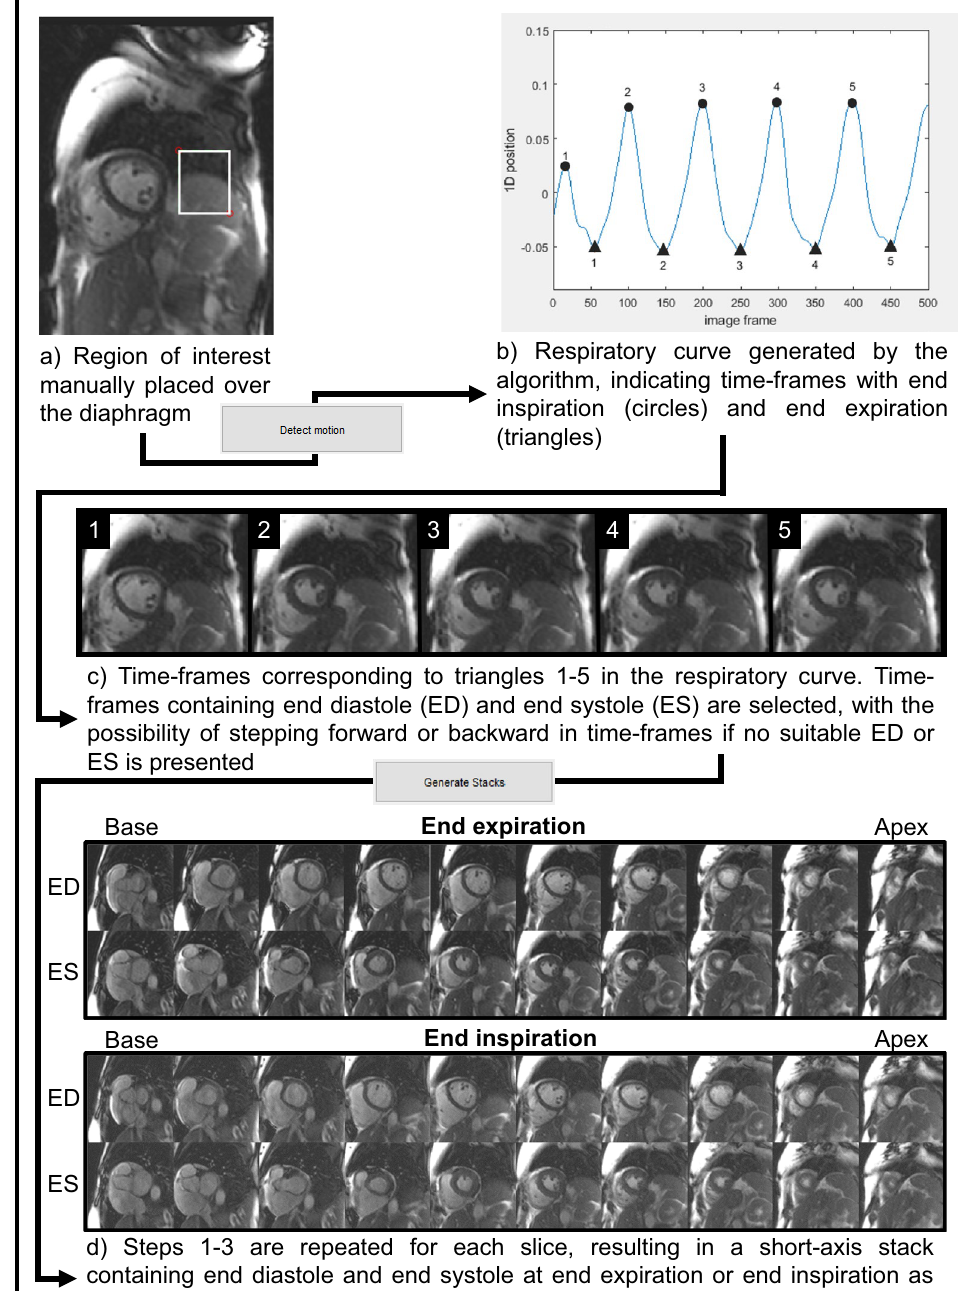
Figure 1. Flow chart for the respiratory module in Segment. The respiratory module in Segment utilized manual input to construct short-axis image stacks containing end diastole and end systole at end expiration or end inspiration from real-time CMR images. ( a ) A short-axis image with a respiratory region of interest (ROI, white box) placed over the superior border of the diaphragm. ( b ) The respiratory curve generated by the algorithm based on calculations from the placed ROI. Here the filled triangles annotate time-frames in which end expiration was identified, filled circles end inspiration. ( c ) An image gallery of the corresponding time- frames to the annotations in the respiratory curve (end expiration shown in the figure). These images were used for selecting time-frames in which end diastole and end systole coincide with end expiration. It was possible to manually step forward or backward several time-frames in each image if no suitable time-frames for end diastole or end systole were automatically suggested. While stepping forward or backward in time-frames the corresponding annotation moved in the respiratory curve, which allowed the user to ensure the current time- frame was still within end expiration or end inspiration. ( d ) The resulting short-axis image stacks containing end diastole and end systole at end expiration and end inspiration. The software used for this figure was Segment 3.0 ( http:// segme nt. heibe rg. se